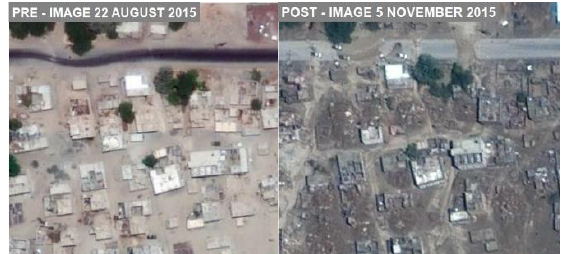
Figure 1. Destruction of road and infrastructure in the Al Mukalla city region (Photos from the